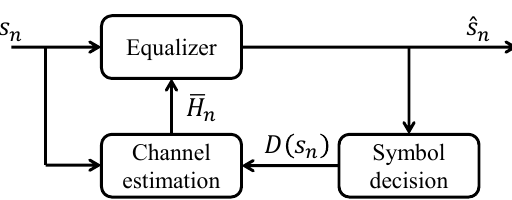
Figure 3. A block-diagram description of a general equalizer. All equalizers discussed in this section follow the same structure, with the differences being in the operation of the channel estimation and equalization